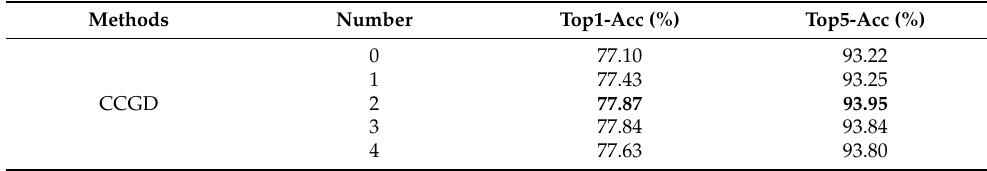
Table 5. The results of using different numbers of difference maps on ImageNet dataset with ResNet- 50 backbone. Results in bold are the best in each